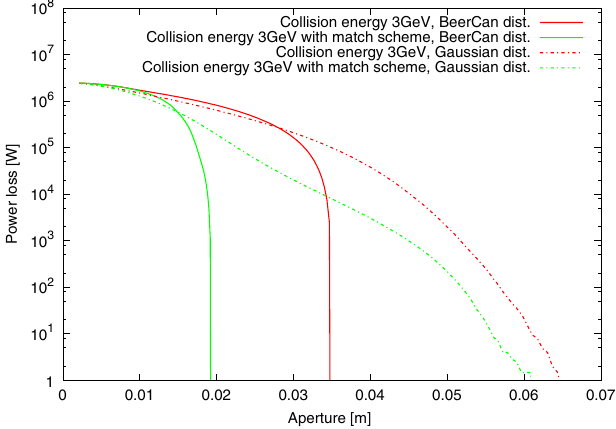
FIG. 19. (Color) Power loss at 10 MeV with or without matching scheme for low collision energy setup (3